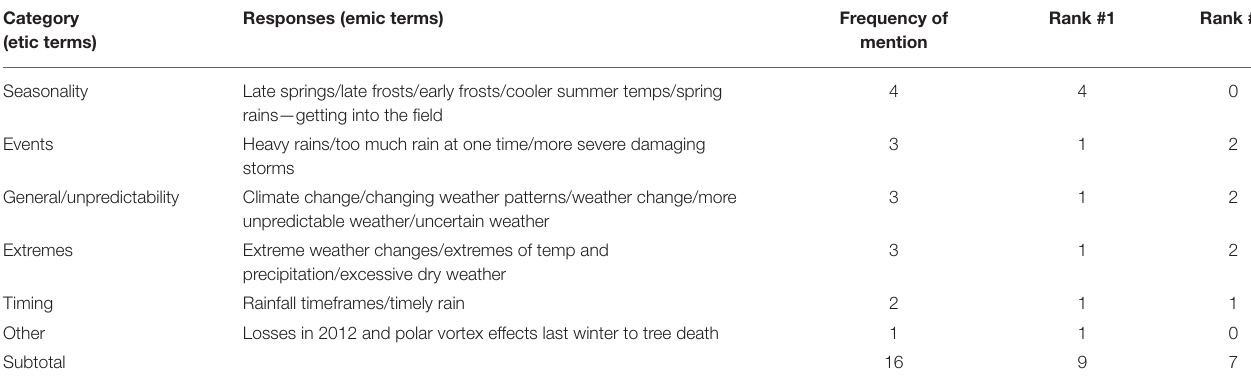
TABLE 4 | Research question 1: Climate change-type responses, with frequency and rank in the